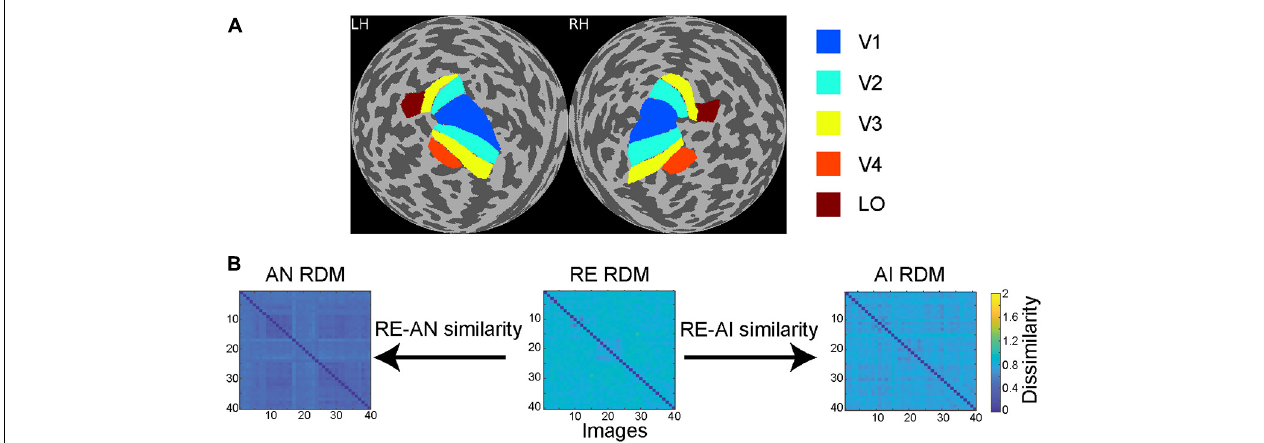
FIGURE 2 | (A) Regions of interest (ROIs) in a sample subject. Through retinotopic mapping and functional localizer experiments, we identified five ROIs—V1, V2, V3, V4 and lateral occipital (LO) cortex—in both left (LH) and right (RH) hemispheres. (B) Calculation of RE-AN and RE-AI similarity. For each CNN layer or brain ROI, three RDMs are calculated with respect to the three types of images. We then calculate the Spearman correlation between the AN and the RE RDMs, obtaining the RE-AN similarity. Similarly, we can calculate the RE-AI similarity.